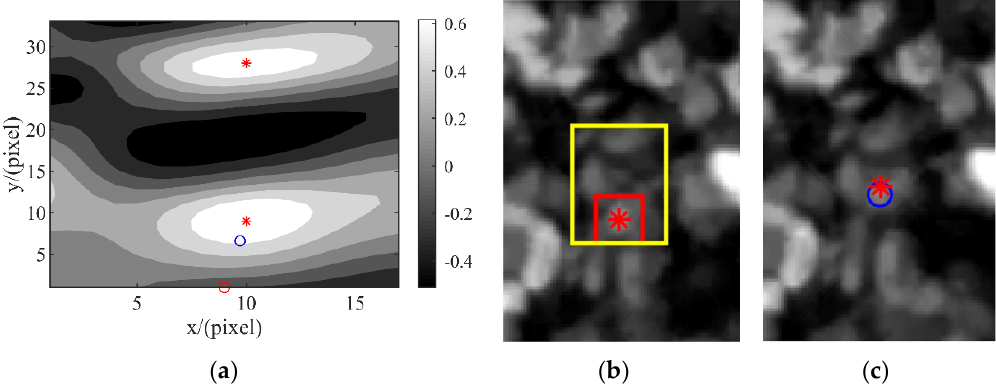
Figure 6. ( a ) Contour map of correlation coefficients; ( b ) moving particle at the first image; ( c ) moving particle at the second image. The peaks, initial position, and predicted position are represented by red stars, red circle, and blue circle, respectively. Red square and yellow square represents the diagnostic window and searching area, respectively.